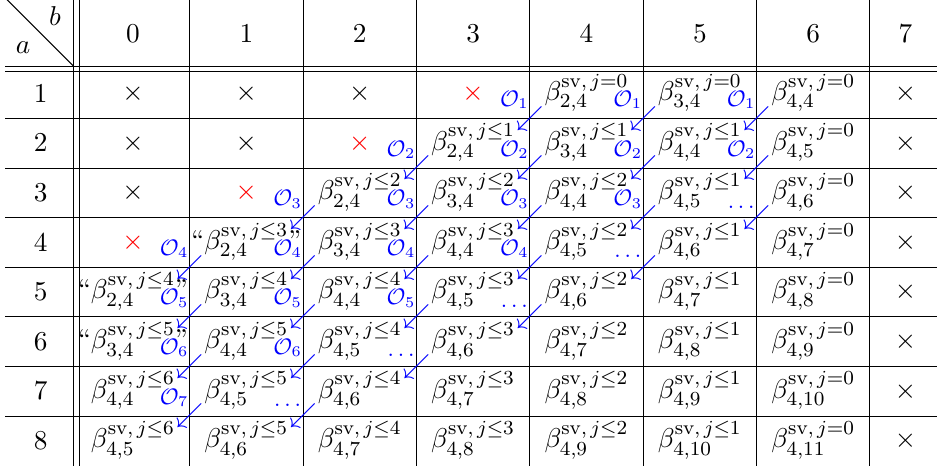
Table 5 . Leading-depth terms β sv ,j y a E 0 (8 , 0 b ) including the alternative seeds.